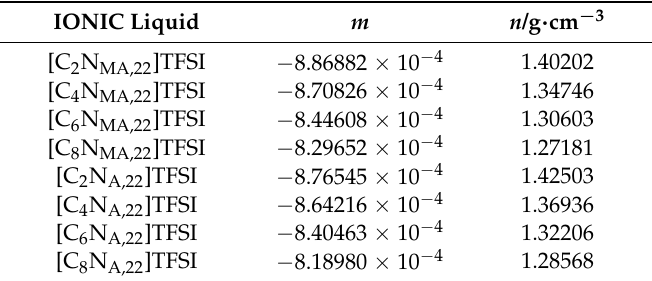
Figure 2. Density values of the synthesized TFSI-Ionic Liquids. Table 3. Parameters from linear fit of density values ( y = m × x + n Table 3. Parameters from linear fit of density values ( y = m × x + n ).